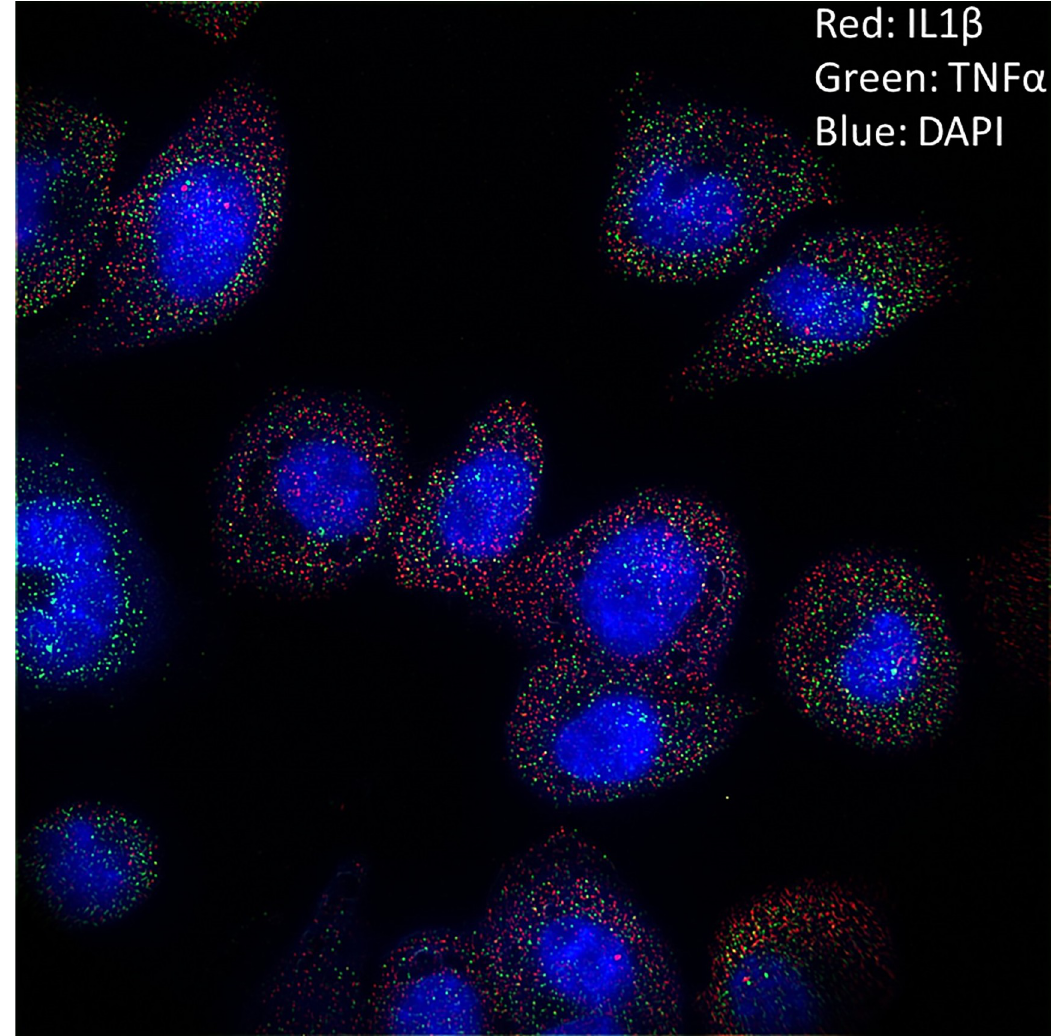
Fig 5. Simultaneous mRNA imaging of IL1 β and TNF- α for single-cell corrolation of mRNA content. This image was taken after 1 hr of LPS stimulation and exhibited relative high expression of both TNF- α (green) and IL1 β